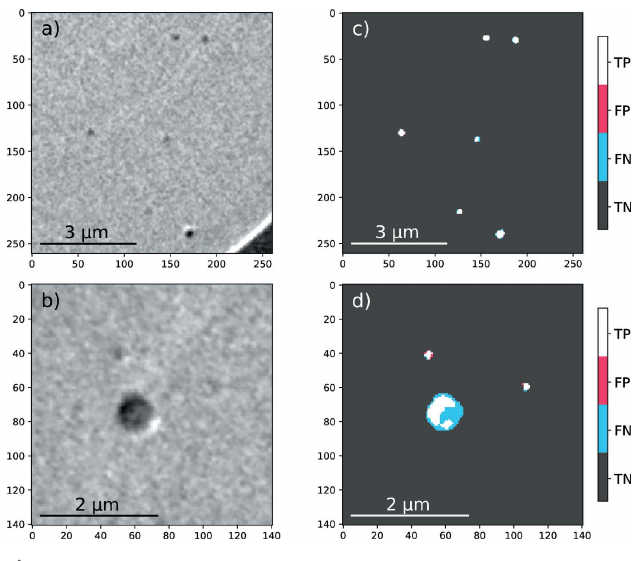
Figure 5 TXM raw data ( a and b ) and hit map ( c and d ). TP: true positive; FP: false positive; FN: false negative; TN: true